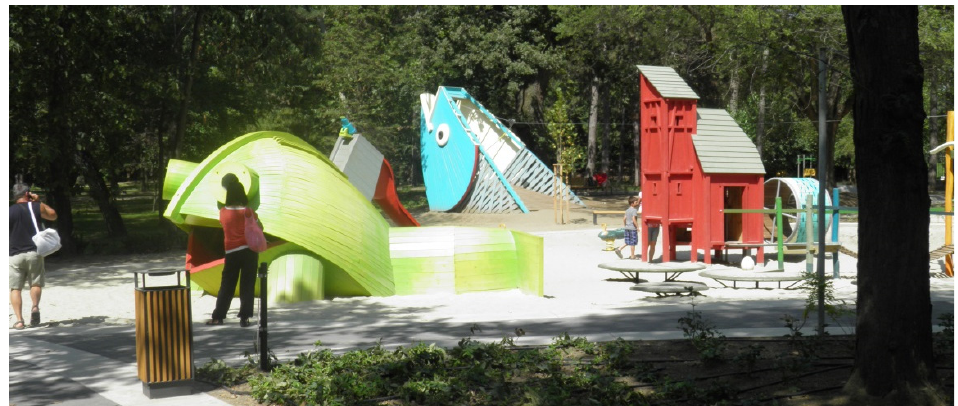
Figure 16. Playground for children in the western part of the Great Forest Park. Source: own collection.